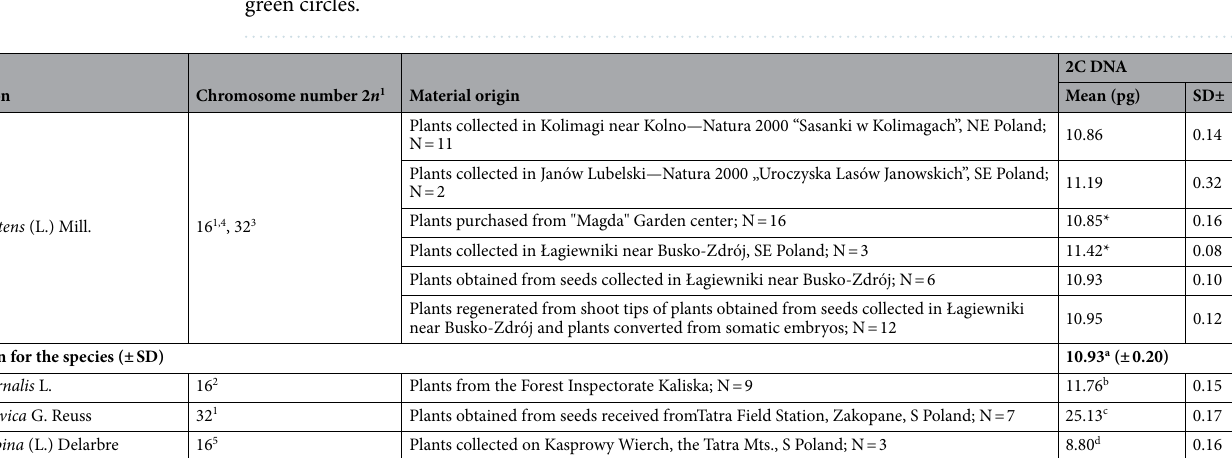
Table 4. Chromosome number and genome size (2C DNA) of different Pulsatilla species. Mean 2C DNA values for groups within P. patens marked with * differ significantly according to Kruskal–Wallis test. Mean 2C DNA values for each species marked with different letters (a–d) differ significantly according to one-way ANOVA and a Tukey’s HSD post-hoc test for different N. SD–standard deviation. 1 From 39 . 2 From 40 . 3 From Löve 1954 (cited from 40 ). 4 Present paper. 5 From 41